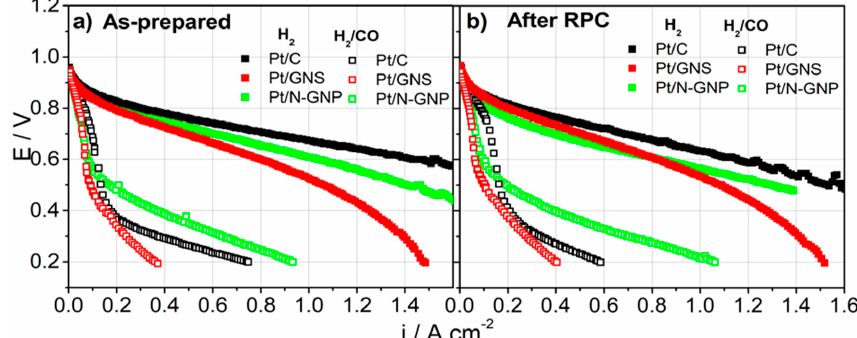
Figure 6. V/j curves of PEMFCs with Pt/C, P/GNS, and Pt/N-GNP fed with H 2 (closed symbols) and H 2 /100 ppm CO (open symbols) as-prepared ( a ) and following ( b ) RPC. ppm CO (open symbols) as-prepared ( a ) and following ( b ) RPC. Catalysts 2020 , 10 , x FOR PEER REVIEW